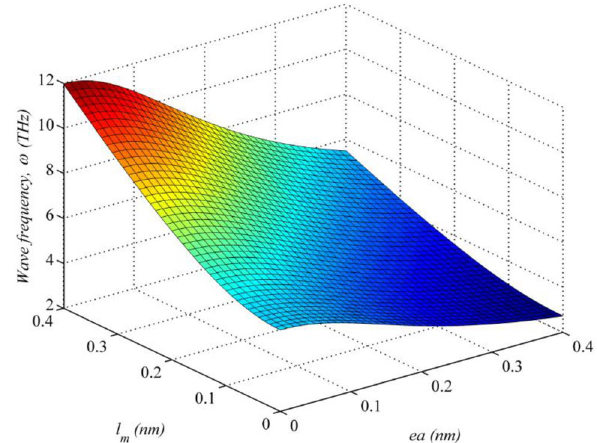
Fig. 7 The wave frequency as the wave number function in case of Kn = 0.001 , v = 1000 m ∕ s and B 0 = 100 T avg ( slip )